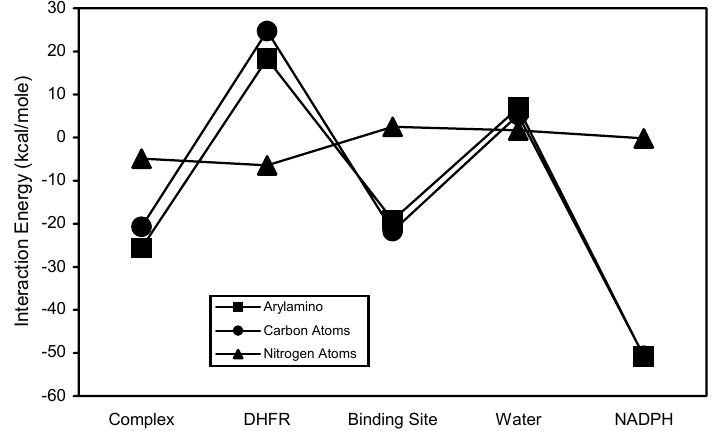
Figure 10. Comparison of interaction energy analysis of the arylamino region of TMQ with its carbon and nitrogen atoms.